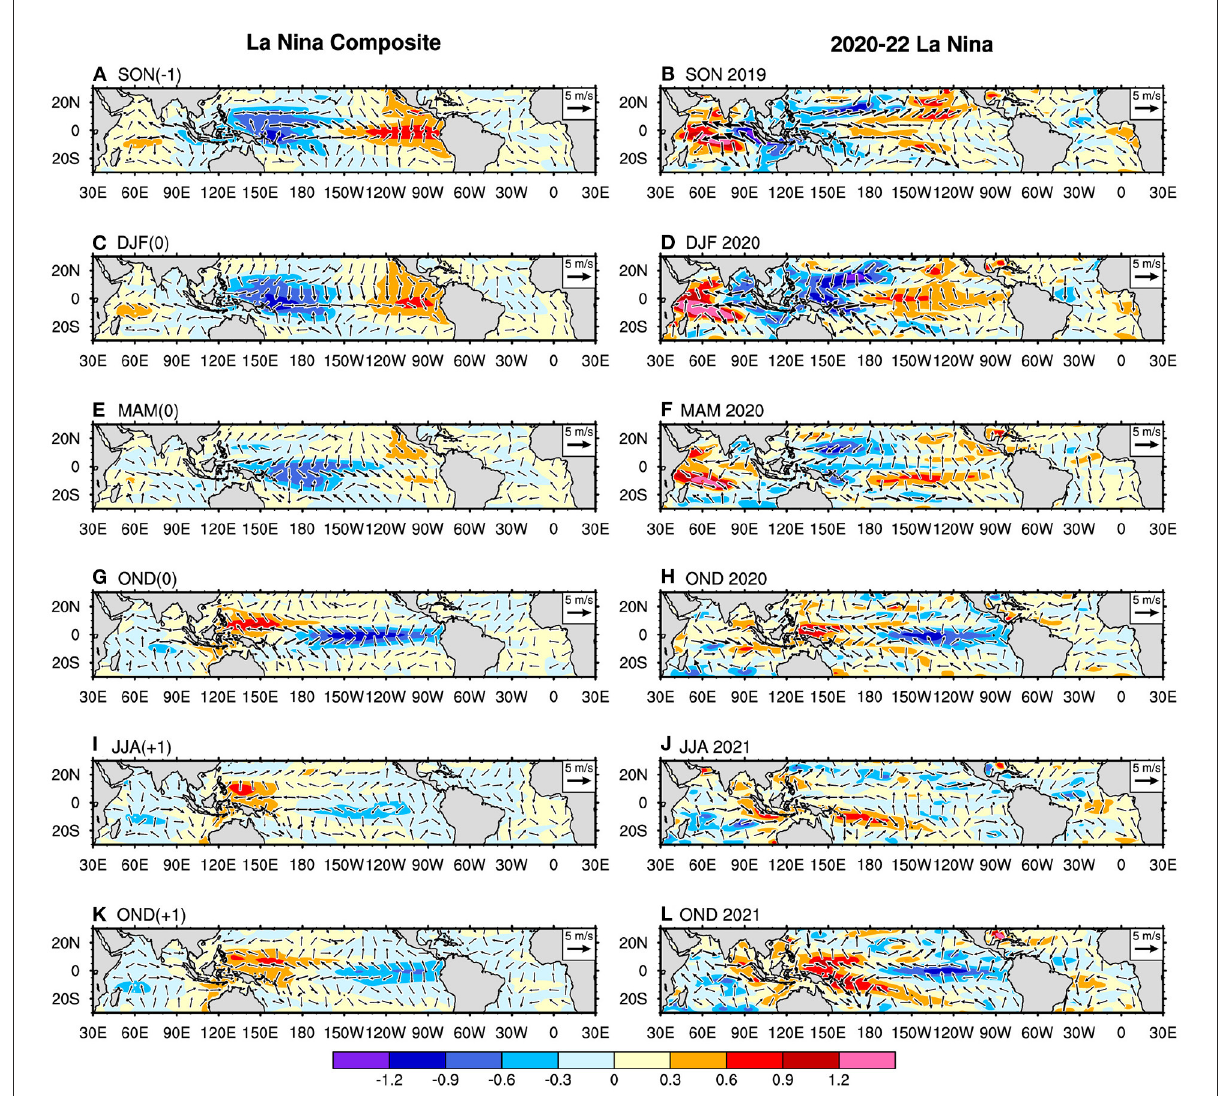
FIGURE3 Temporal evolutions of OHC (in ◦ C indicated by color shading) and surface wind anomalies (vector) in the typical La Niña composite (left) and the 2020–2022 case (right) during the developing stage of (A,B) SON(-1), (C,D) DJF(0), (E,F) MAM(0), (G,H) OND(0), (I,J) JJA(+1), and (K,L) OND(+1). Anomalies are defined as deviations from climatological means, and linear trends are removed in each grid point. The reference vector (5 ms − 1 ) is in the upper right corner. As noted in parentheses after the season abbreviation, 0 indicates the first La Niña year, + 1 indicates the second La Niña year whereas − 1 indicates the preceding year of first La